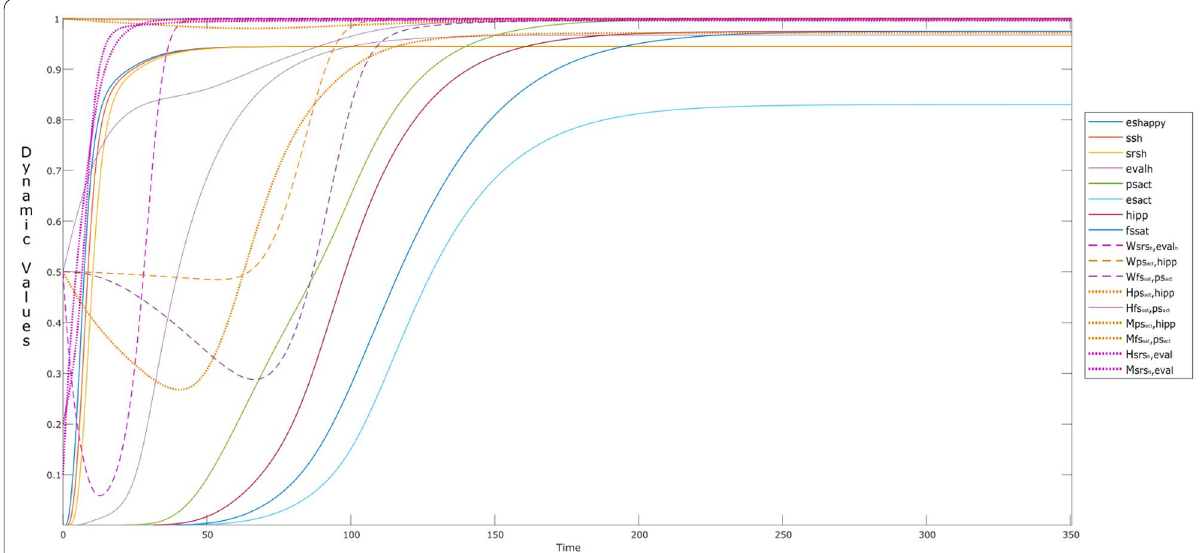
Fig. 6 Dynamics observed when the child learns to be non-narcissistic given (s)he senses happiness (input: eh happy